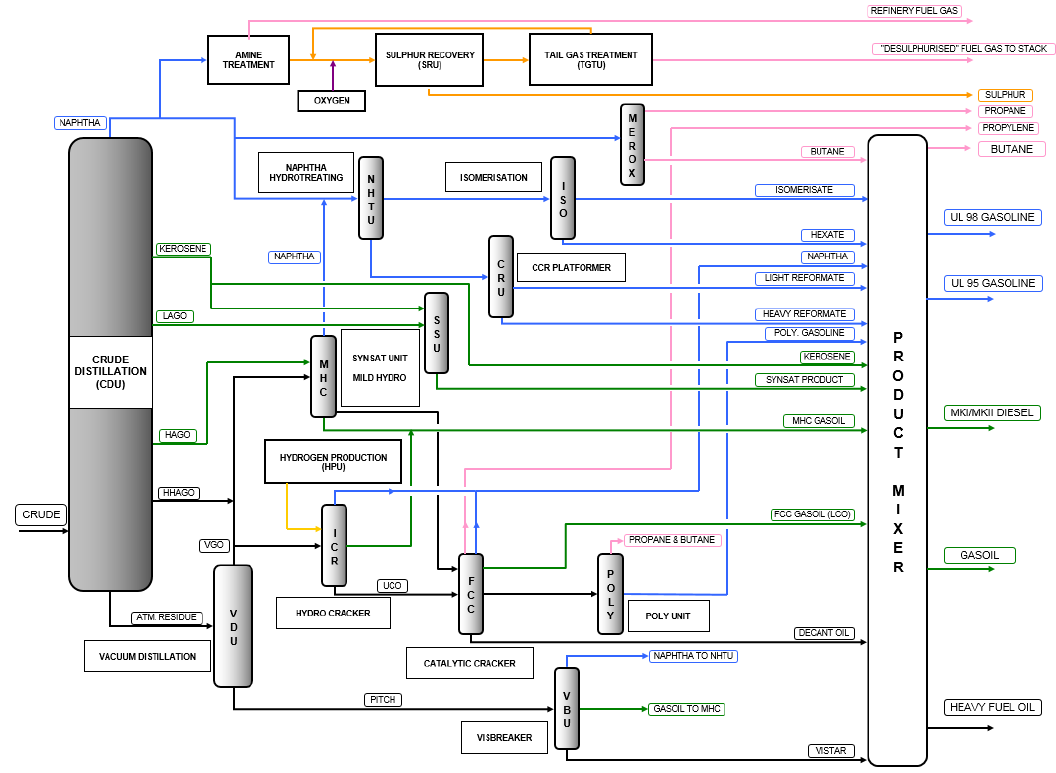
Figure 1. Overview of the main material flows through the refinery processes. Adapted with permission from [41]; Copyright 2013, J.F. Brau. from [41]; Copyright 2013, J.F.